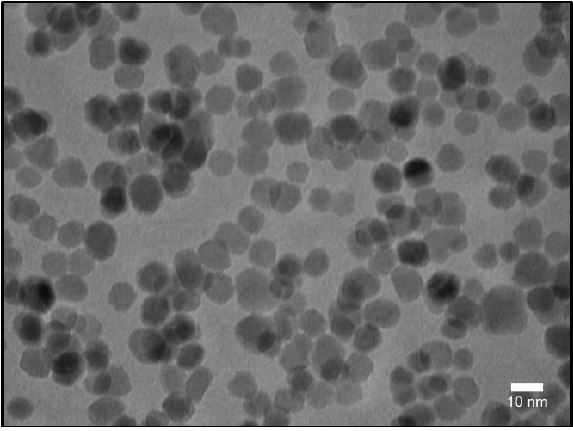
Figure 1. TEM image of the as-synthesized Fe 3 O 4 SPIONs.